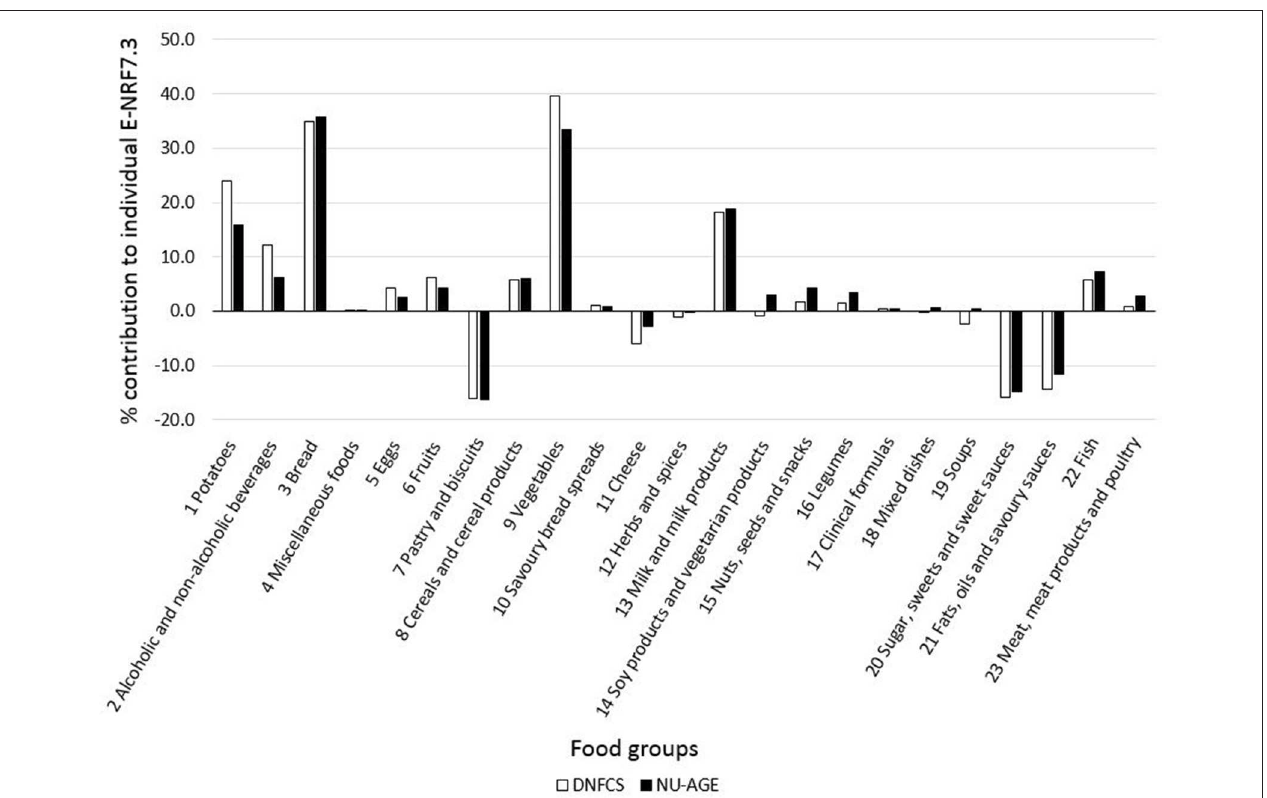
FIGURE 2 | Mean contribution (%) of food groups to individual E-NRF7.3 scores in both DNFCS ( n = 735) and NU-AGE ( n =